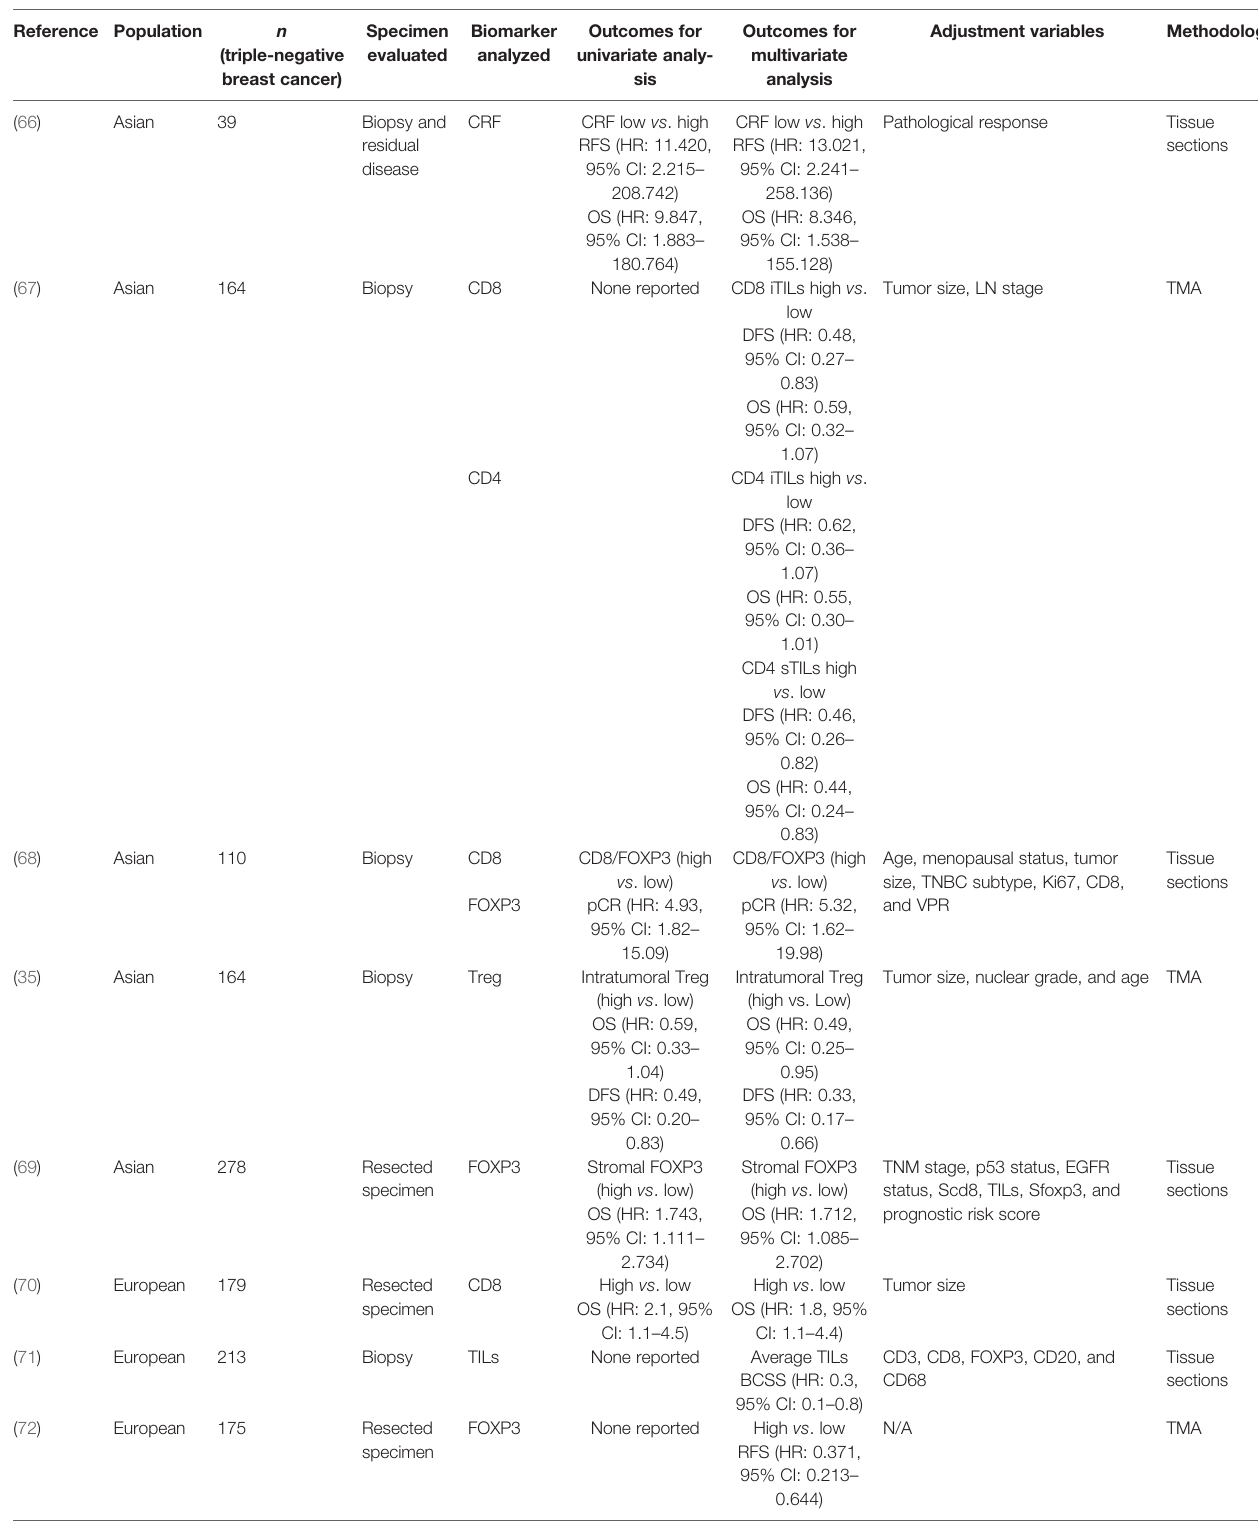
TABLE 2 | Outcomes from studies that analyzed tumor-in fi ltrating lymphocytes (TIL) subpopulations according to the region of